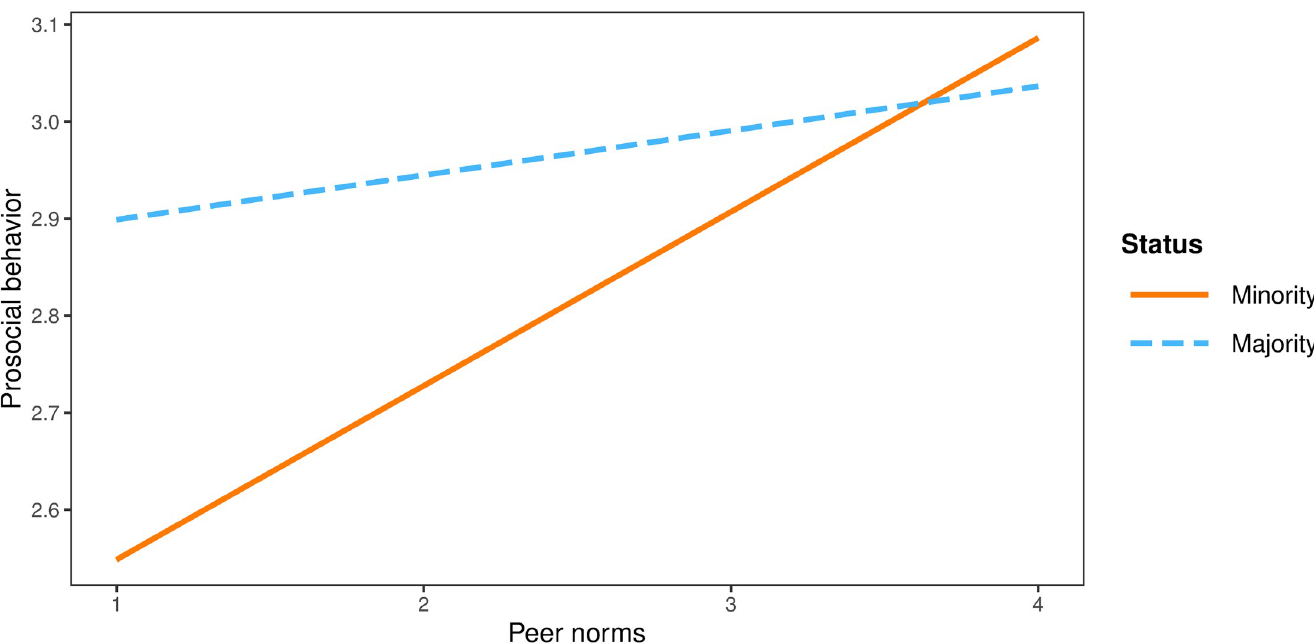
Fig 3. Interaction plot between peer norms and group status on prosocial behaviour.